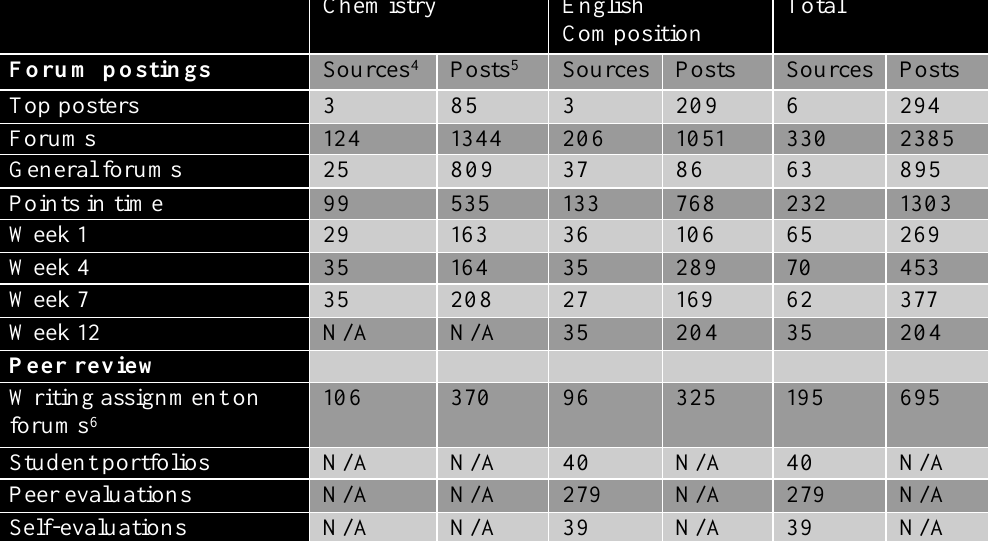
Table 4 Number of Items Coded and Scores